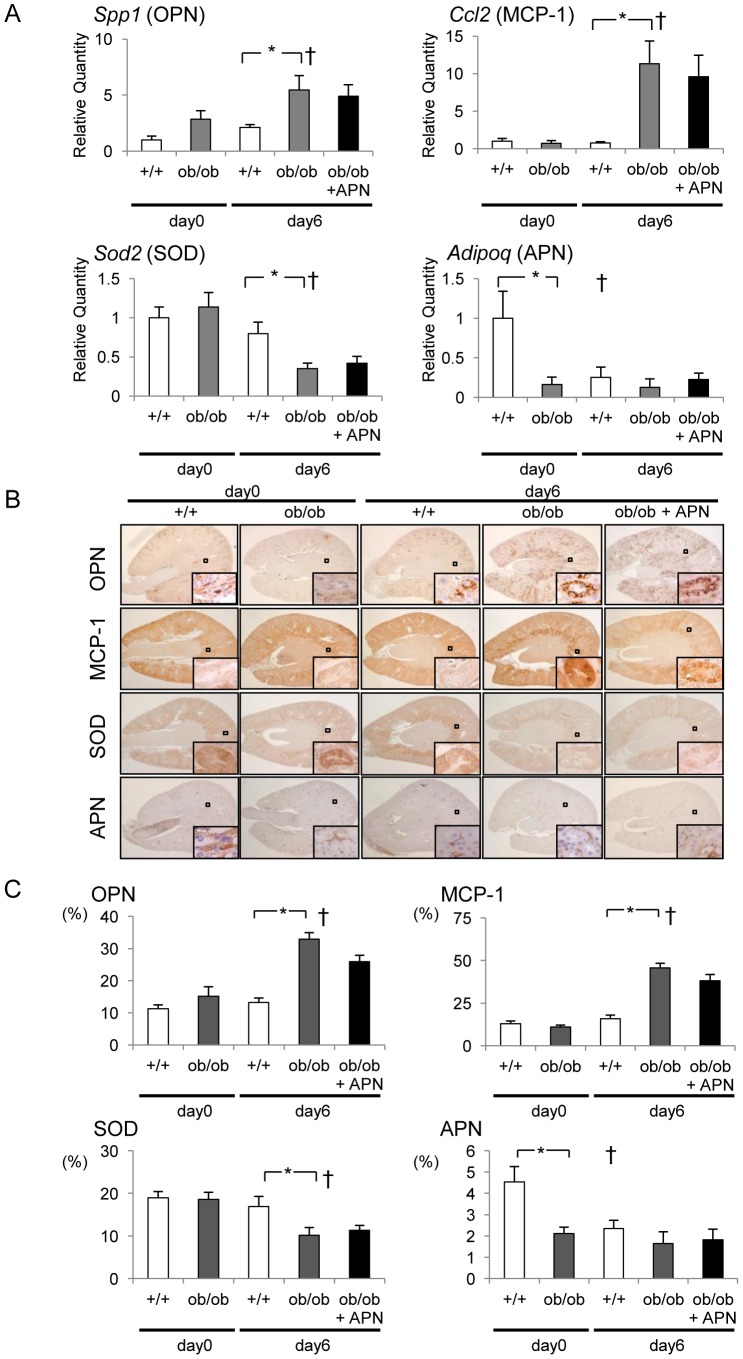
Expression analyses of Spp1, Sod2, Ccl2, and Adipoq.A. The results of quantitative PCR for the expression of Spp1, Sod2, Ccl2, and Adipoq. Expression levels are expressed relative to Actb (actin-beta) transcript levels. Spp1, secreted phosphoprotein 1; Ccl2, C-c chemokine ligands 2; Sod2, superoxide dismutase 2; Adipoq, adiponectin. Data are indicated as the mean ± SE. *, p<0.05 between groups at the same time point. †, p<0.01 compared with the same group at day 0. B. Immunohistochemical staining for OPN, MCP-1, SOD, and APN expression. OPN, osteopontin; MCP-1, monocyte chemotactic protein-1; SOD, superoxide dismutase; APN, adiponectin. Magnification is ×20 (in box: ×400). C. The quantification of immunohistochemical staining. Data are indicated as the mean ± SD. *, p<0.05 between groups at the same time point. †, p<0.05 compared with the same group at day 0.